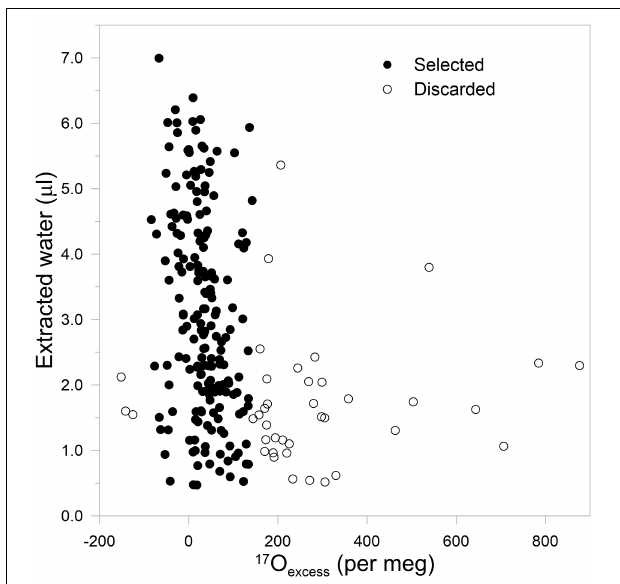
FIGURE 5 | Difference between 17 O excess values calibrated using our protocols and scaled calibrated δ 17 O and δ 18 O values with zero offset normalization and slope correction. The gray shaded area corresponds to the range when taking an uncertainty of ± 20 per meg (standard deviation of the normalized values).